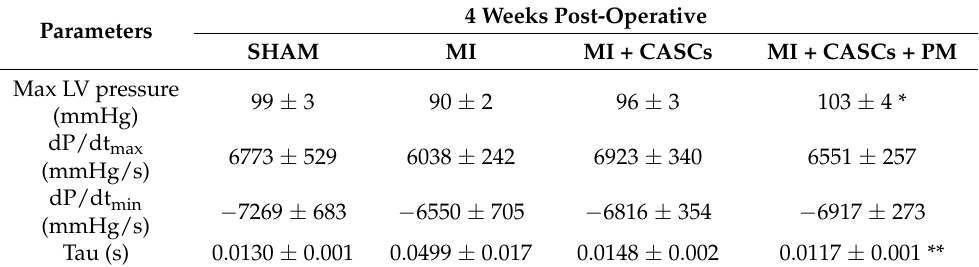
Hemodynamic characteristics 4 weeks post-op of SHAM ( n = 5), MI ( n = 9), MI + CASCs ( n = 10), and MI + CASCs + PM ( n = 9) animals. Data are expressed as mean ± SEM. * denotes p < 0.05 and ** denotes p < 0.01 vs. MI. LV: left ventricular, dP/dt max : peak rate of pressure rise, dP/dt min : peak rate of pressure decline, Tau: time constant for isovolumetric relaxation.